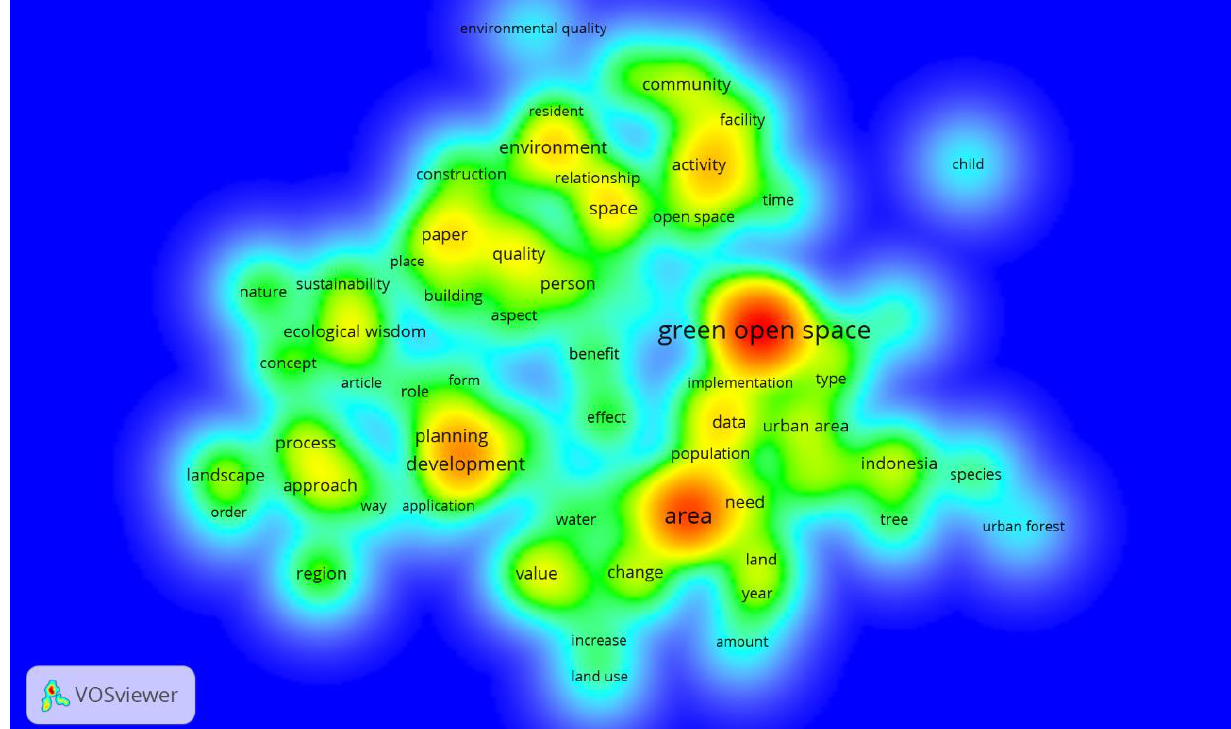
Fig. 8. Terms density visualization of both